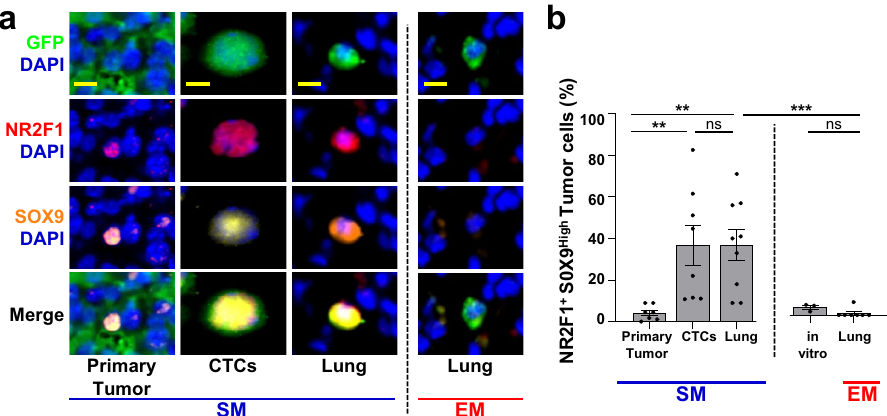
Fig. 5 Spontaneously metastasizing tumor cells are more frequently doubly positive for dormancy and stem-like markers compared to intravenously injected tumor cells. a Representative images of triple immuno fl uorescence staining for GFP, NR2F1, and SOX9 expression in primary tumors, circulating tumor cells (CTCs), and disseminated tumor cells (Lung) from an E0771-GFP SM model (Left) and in disseminated tumor cells (Lung) from an EM model (Right). Green = GFP; Red = NR2F1; Orange = SOX9; Blue = DAPI. Scale bar for Primary Tumor = 50 μ m. Scale bar for CTCs and Lung = 15 μ m. b Percentage of double-positive tumor cells NR2F1-positive SOX9 High from each group in Fig. 5a. Primary Tumor: n = 2383 in 97 fi elds of view (65 × 65 µ m 2 ) in 7 animals; CTCs: n = 379 cells in 8 animals; SM Lung: n = 104 cells in 9 animals; In vitro: n = 413 cells in 3 independent experiments. EM Lung: n = 75 cells in 7 animals. Bar = mean. Error bars = ±SEM. For EM Lung vs. SM Lung ( p = 0.0001) and EM Lung vs. in vitro ( p = 0.69), a two-tailed Kruskal-Wallis test with Dunn ’ s multiple comparisons adjustment was used. For PT vs . CTC: ( p = 0.0041), PT vs. Lung SM ( p = 0.0030), and CTC vs . Lung SM ( p = 1.00) a two-tailed ANOVA test with Sidak ’ s multiple comparisons adjustment was used. ** p < 0.01. *** p < 0.001. ns = not signi fi cant. Source data are provided as a Source Data fi